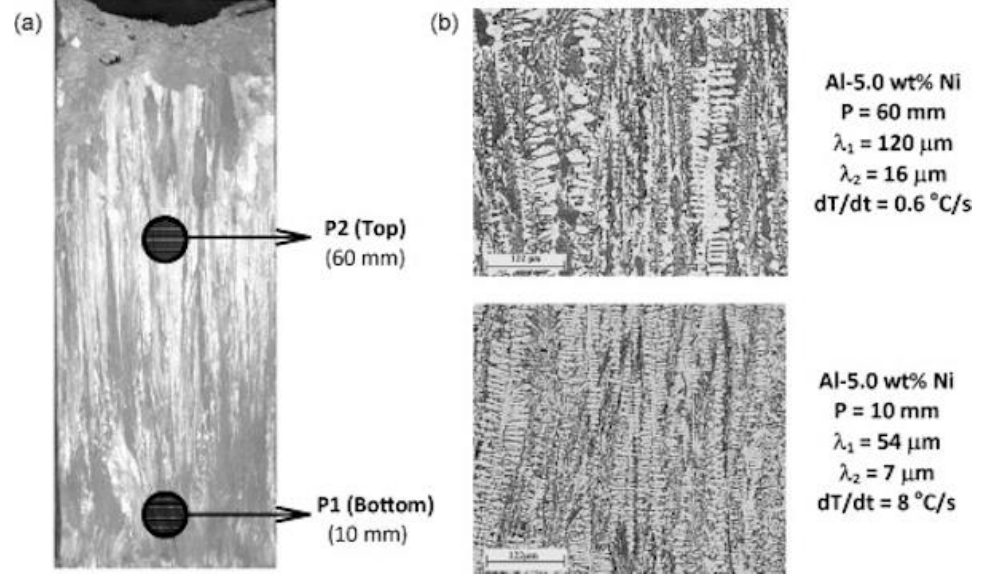
Figure 11. ( a ) Typical macrostructure of the as-cast Al–5 wt % Ni alloy and schematic representation of positions from where the samples were extracted for corrosion tests and ( b ) optical micrographs with corresponding dendritic spacings ( λ 1 and λ 2 are the primary and secondary dendritic spacings, respectively) and cooling rates. Reprinted with permission of [24].